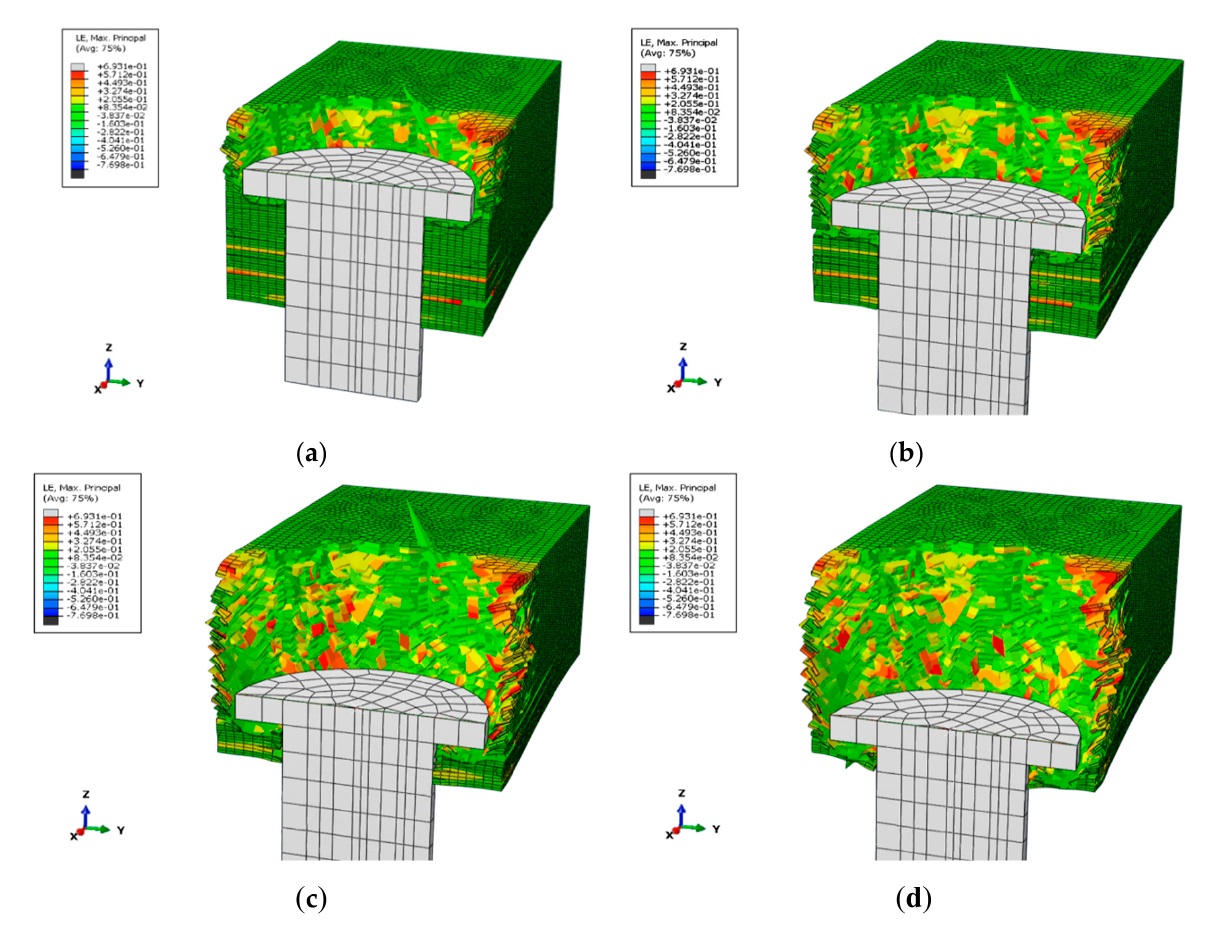
Figure 10. Matrix tensile damage distribution under load of different percentage: ( a ) load intensity 5 × 10 − 2 to 25 × 10 − 2 , ( b ) load intensity 25 × 10 − 2 to 50 × 10 − 2 , ( c ) load intensity 50 × 10 − 2 to 75 × 10 − 2 , ( d ) load intensity 75 × 10 − 2 to 100 × 10 − 2 .